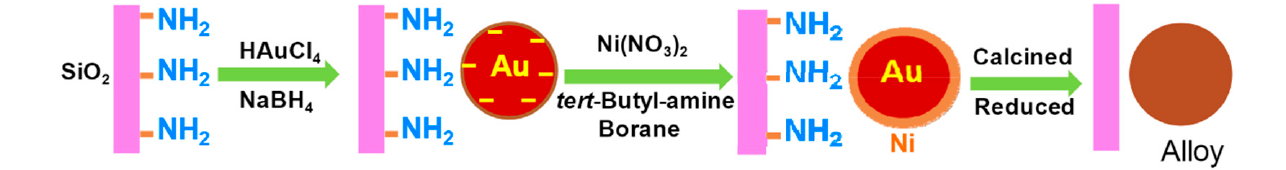
Figure 5. Synthetic diagram of Ni-Au alloy formation. Adapted from [11].